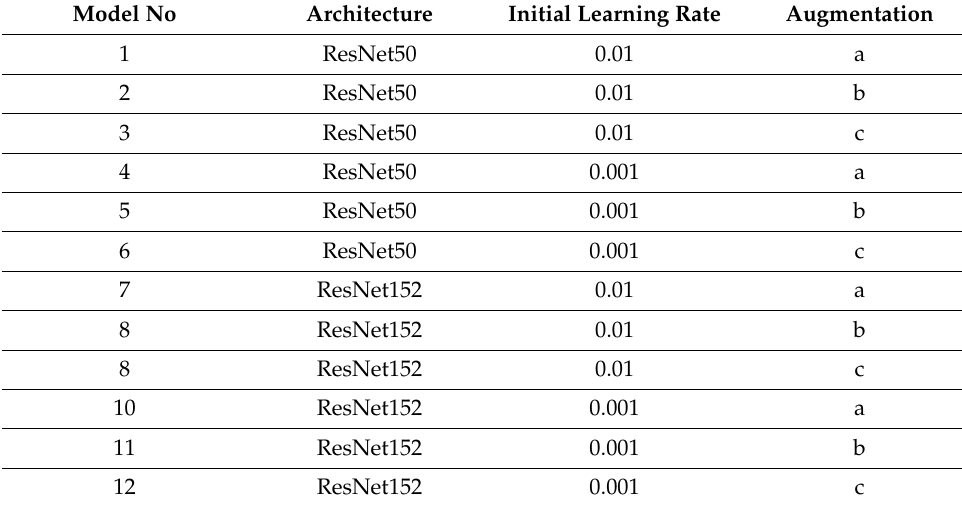
Table 1. Training conditions of